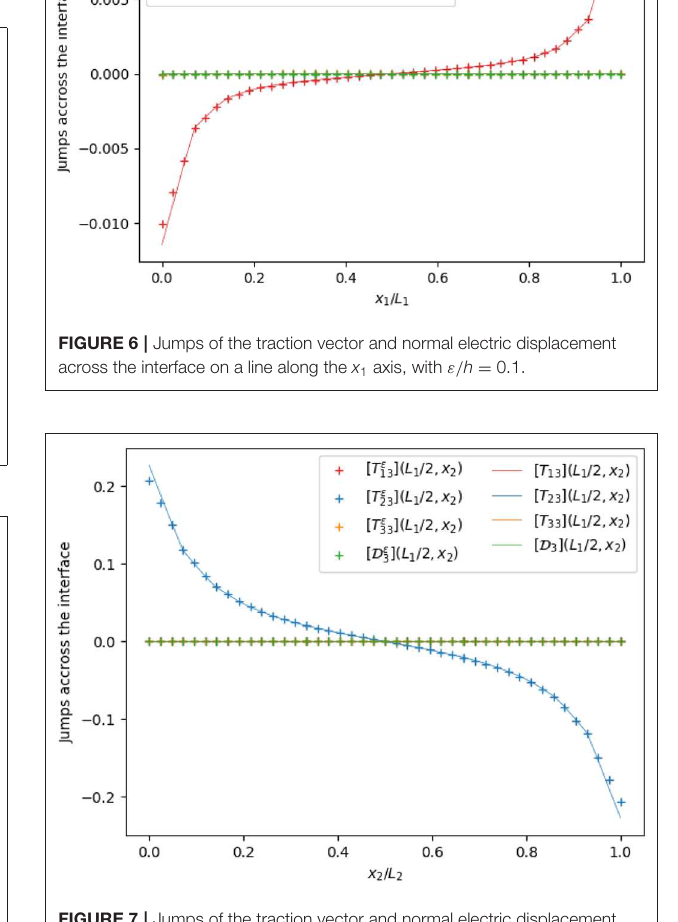
FIGURE 7 | Jumps of the traction vector and normal electric displacement across the interface on a line along the x 2 axis, with ε/ h =